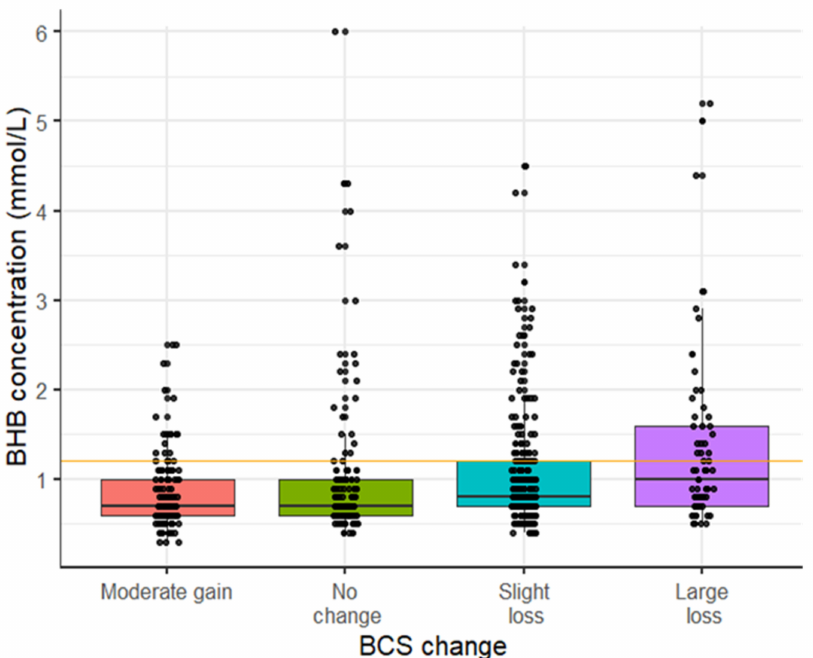
Figure 1. Distribution of BHB concentration during the first two weeks postpartum according to BCS change in the late dry period. Each point represents the highest BHB concentration measured during the first two weeks postpartum for each individual cow. BCS change was calculated subtracting the BCS at − 21 days prepartum from the BCS measured at calving, and categorized as gain ( ∆ BCS 0 to 0.5), no change ( ∆ BCS = 0—reference), moderate loss ( ∆ BCS range: − 0.5 to <0), or large loss ( ∆ BCS > − 0.5). Number of cows with moderate gain = 130; no-change = 117, moderate loss = 247, and large loss = 65. The HYK incidence was for moderate gain 16.0%, no-change = 17.9%, moderate loss = 26.7%, and large loss =